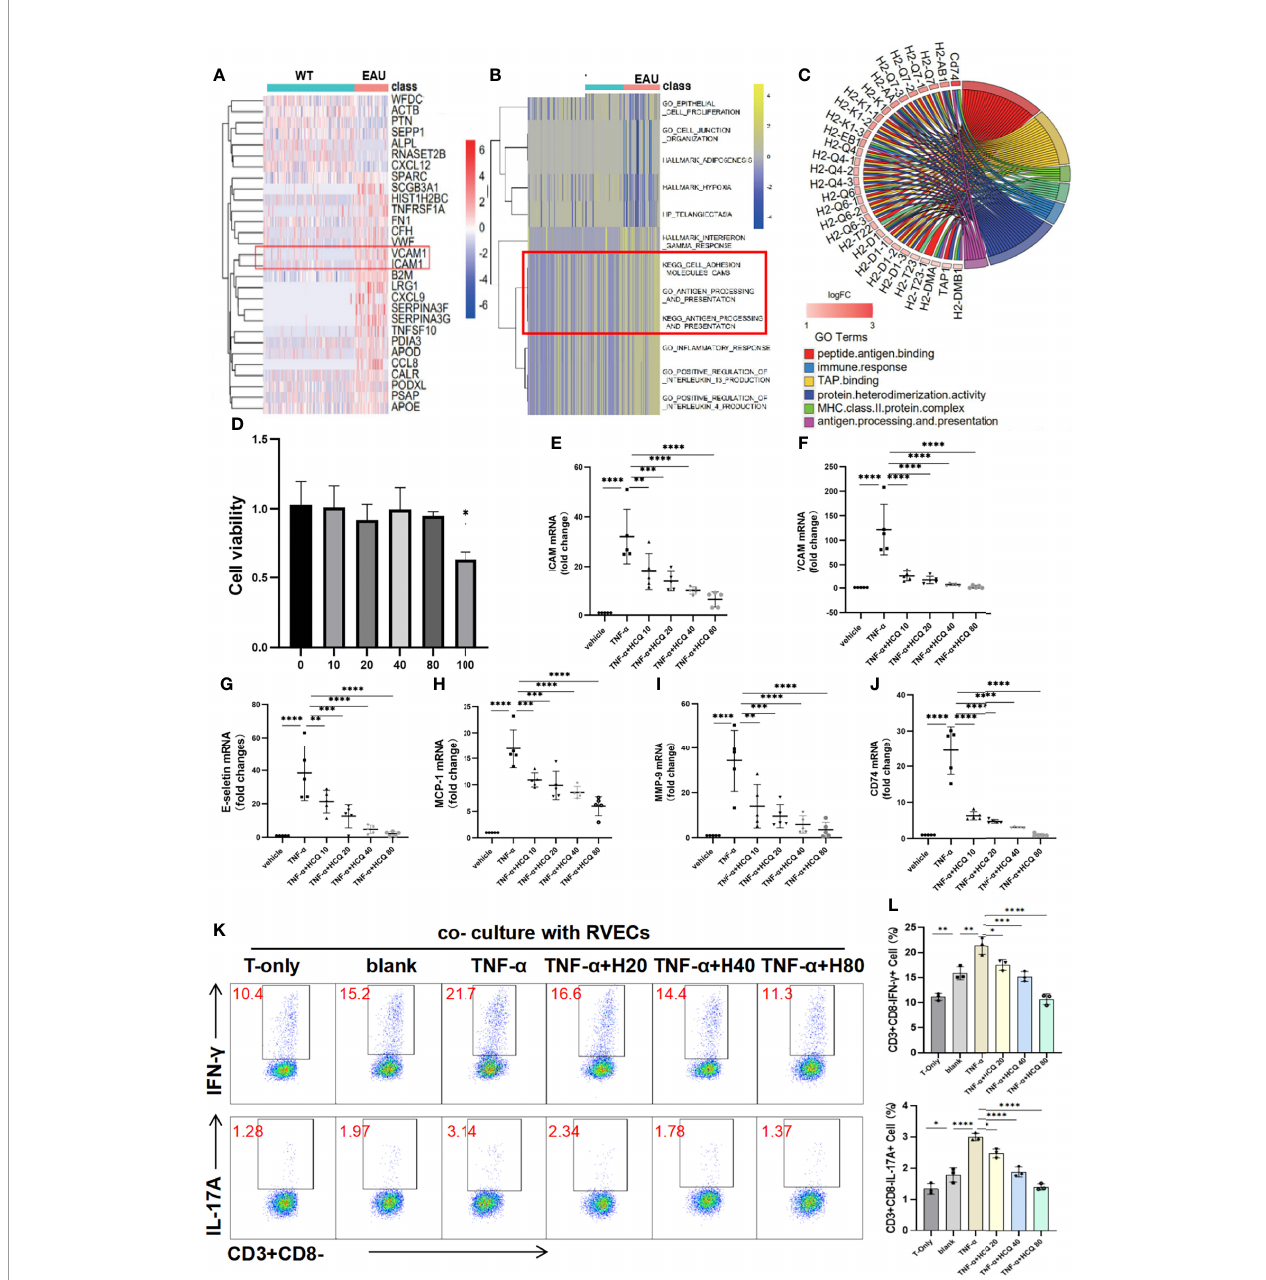
FIGURE 4 | Hydroxychloroquine (HCQ) alleviates retinal vascular endothelial cells (RVECs) dysfunction induced by in fl ammation. (A) Differentially expressed genes (DEGs) were explored and are reported in a heatmap of mRNA abundance. Rows denote expression of RNAs according to their enrichment in WT and spontaneous experimental autoimmune uveitis (EAU). (B) The heatmap of the gene ontology (GO) and Kyoto encyclopedia of genes and genomes (KEGG) analyses showed that compared with the WT group, uveitic RVECs presented with enhanced in fl ammatory response, cell adhesion molecules CAMS, and antigen processing and presentation. (C) Chord chart equally illustrates that the antigen presentation mediated by MHC-II molecules was signi fi cantly enhanced in RVECs of EAU mice. The in fl ammatory dysfunction of RVECs was induced by TNF- a stimulation. (D) The toxic effects of HCQ on the cell viability of RVECs were measured by CCK8 assay. RVECs were incubated with 10, 20, 40, 80 and 100 m M HCQ for 48 h, and 100 m M HCQ induced cytotoxicity on RVECs (N=3). (E – J) RT-qPCR results show that in the model of RVEC dysfunction, the expression of ICAM, VCAM, E-selectin, MCP-1, MMP-9, and CD74 mRNAs in the retina was markedly upregulated, whereas HCQ (10, 20, 40, and 80 µM) considerably and dose-dependently decreased the expression of these mRNAs (N=5). (K, L) Flow cytometry analysis shows that the T cells were activated and produced more IL-17 and IFN- g after coculture with RVECs, especially with TNF- a – stimulated RVECs. Pretreatment of TNF- a – stimulated RVECs with HCQ resulted in lower cytokine production in T cells (N=3). The data are presented as the mean ± SD (*P < 0.05, **P < 0.01, ***P < 0.001, ****P <